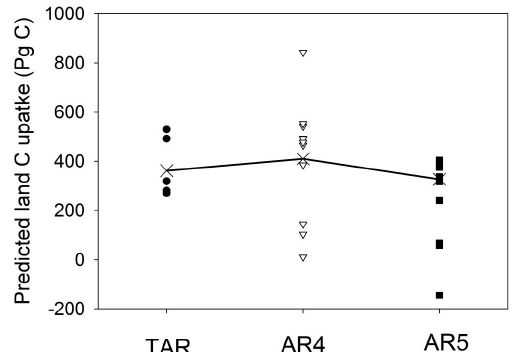
Figure 4. Simulated land carbon uptake to 2100 under a “high-end” global warming scenario, as projected by global models in the IPCC Third Assessment Report (TAR), Fourth Assessment Report (AR4) and Fifth Assessment Report (AR5). The cross represents the mean of the models included in each assessment.